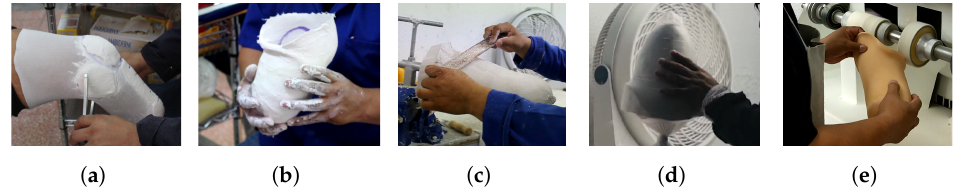
Figure 1. The overall process of conventional socket fabrication is shown. ( a ) Starting with the limb measurements. ( b ) Then, a plaster cast is obtained with the residuum geometry. ( c ) Later, the plaster cast model is post-processed by adding and removing material at key locations. ( d ) Next, lamination and curing take place. ( e ) Finally, the socket gets polished and the cut line is